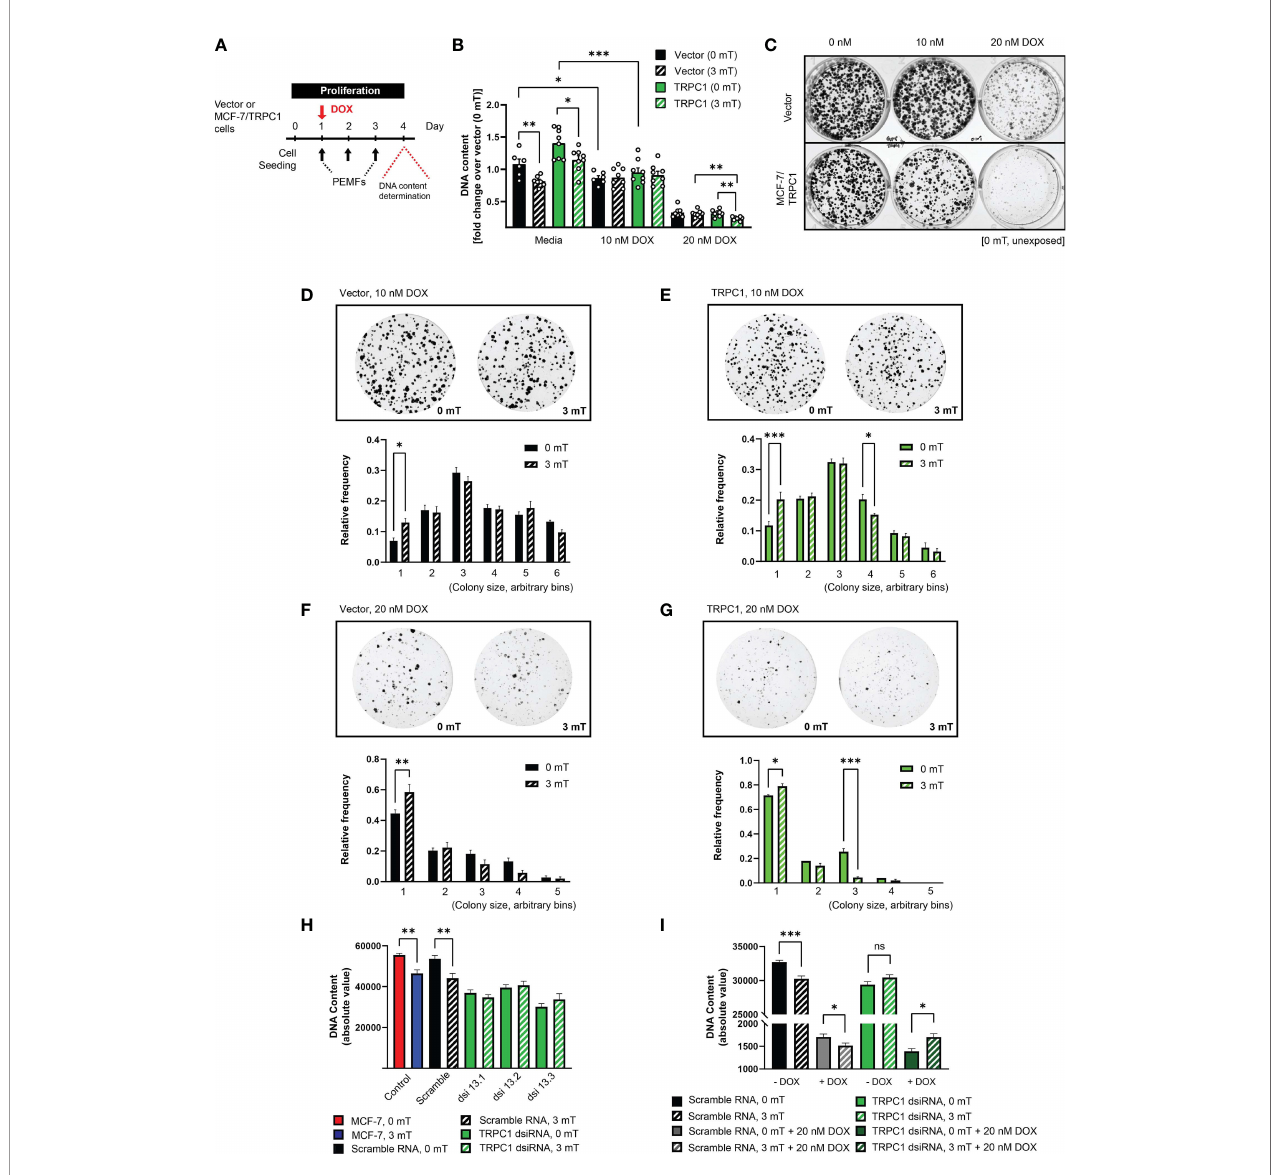
FIGURE 8 | TRPC1 overexpression sensitizes MCF-7 cells to doxorubicin and PEMF exposure. (A) PEMF and DOX treatment regime for MCF-7/TRPC1 cellular DNA quanti fi cation. (B) Quanti fi cation of DNA fold change relative to 0 mT vector cells. Statistical analysis was done using the two-sample t -test. (C) Colony formation after 10 days in the presence of 0 nM, 10 nM or 20 nM DOX, without PEMF exposure. Images of MCF-7 colonies and corresponding colony size frequency distributions normalized to the total number of colonies in the presence of 10 nM DOX for (D) vector and (E) MCF-7/TRPC1 cells or 20 nM DOX for (F) vector and (G) MCF-7/TRPC1 cells, concomitant with daily PEMF exposure. * p < 0.05, ** p < 0.01 and *** p < 0.001 indicate the statistical difference between the respective 0 mT and 3 mT condition within the same bin. (H) PEMF-modulated growth of TRPC1 -silenced MCF-7 cells 48 h post dsiRNA transfection. Cells were transfected with three independent dsiRNA (green), including a scramble RNA (black). Control (untransfected) MCF-7 cells were exposed to 0 mT (red) or 3 mT (blue) PEMFs. (I) Combined effects of PEMF and DOX (20 nM) treatments on the proliferation of TRPC1 -silenced cells. Cells were exposed to PEMFs 24 h and 48 h post dsiRNA transfection before DNA content analysis (hatched bars). The data for TRPC1 dsiRNA (green and dark green) was pooled data from two independent TRPC1 dsiRNAs. The statistical analysis was generated using Multiple unpaired t -test for the comparison of two sample means within the same colony size. All experiments were from 3 to 5 independent experiments with * p < 0.05, ** p < 0.01 and *** p < 0.001. “ ns ” indicates statistically non-signi fi cant differences. The error bars represent the standard error of the